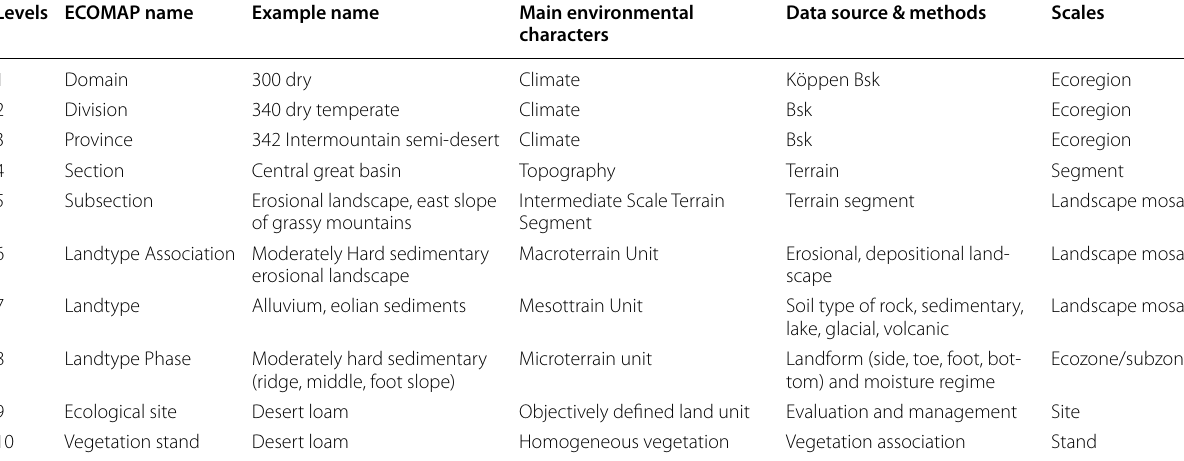
Ecoregion, Ecozone means the classification classes had both biotic and abiotic